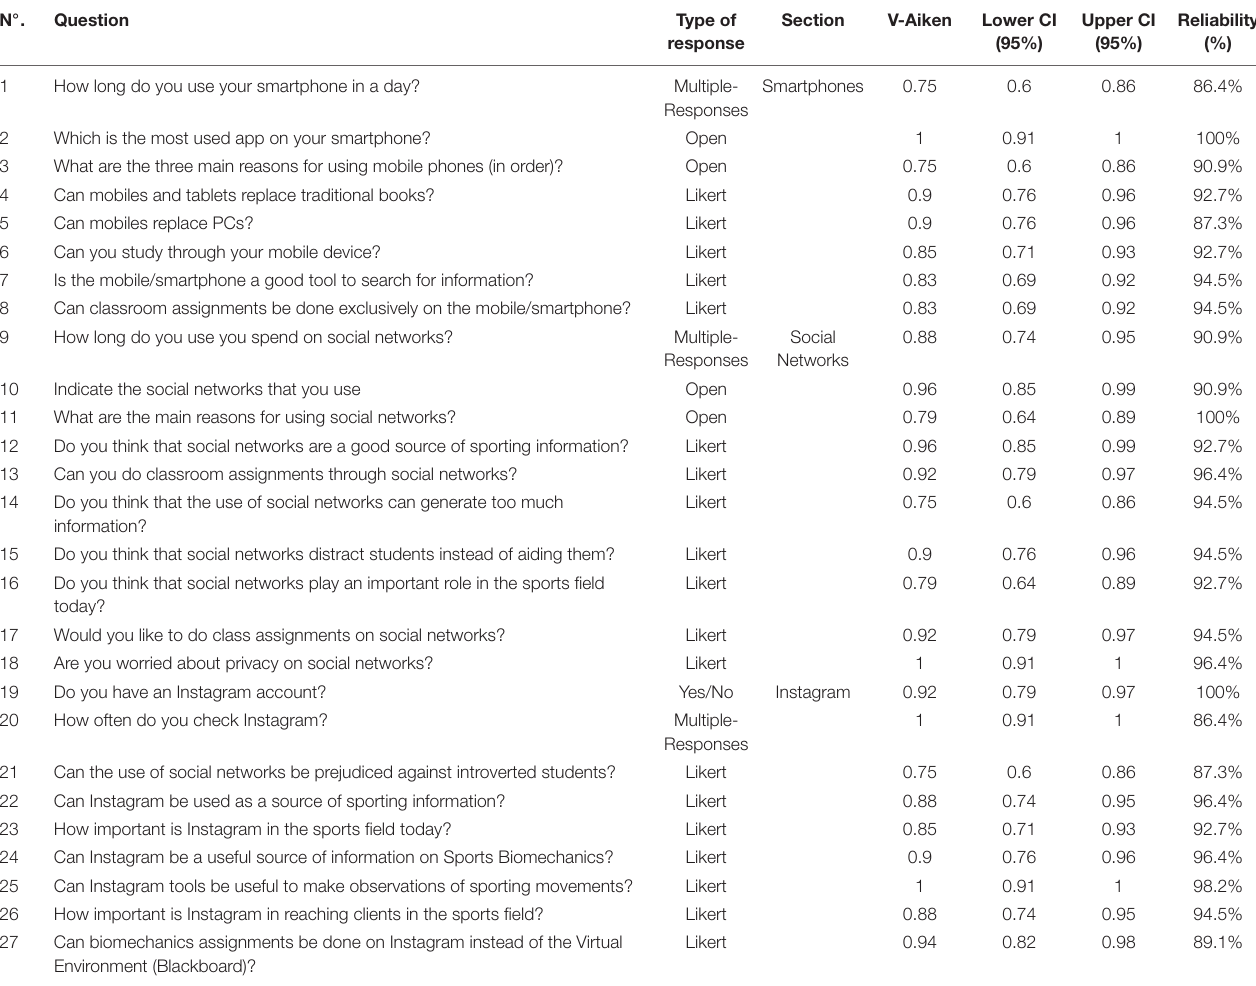
TABLE 1 | The questionnaire passed to the students representing the type of question and the section to which it belonged. For each question, the Aiken’s V validity score (along with its 95% confidence interval (CI)) and its reliability are shown. N ◦ .